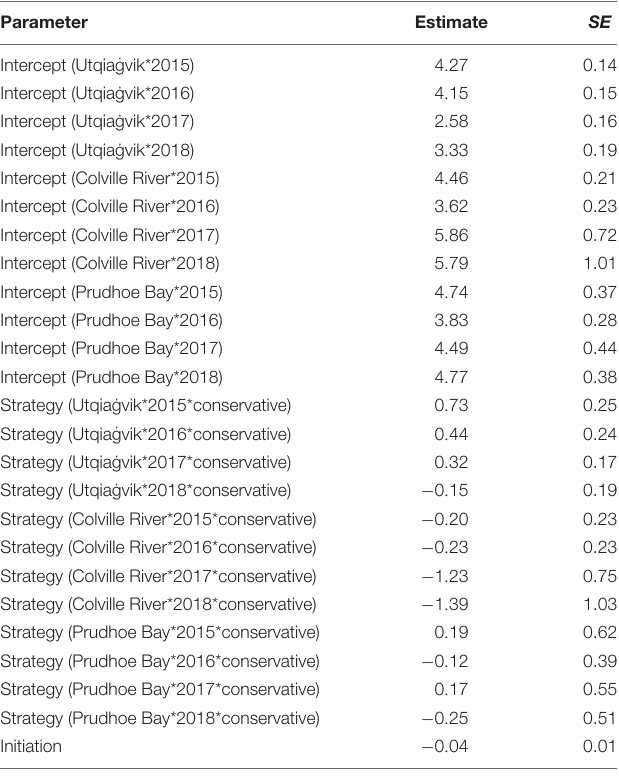
TABLE 6 | Parameter estimates from top-ranked model (site*year*strategy + initiation) explaining variation in daily survival rates of shorebird nests at Utqia˙gvik, Colville River, and Prudhoe Bay,